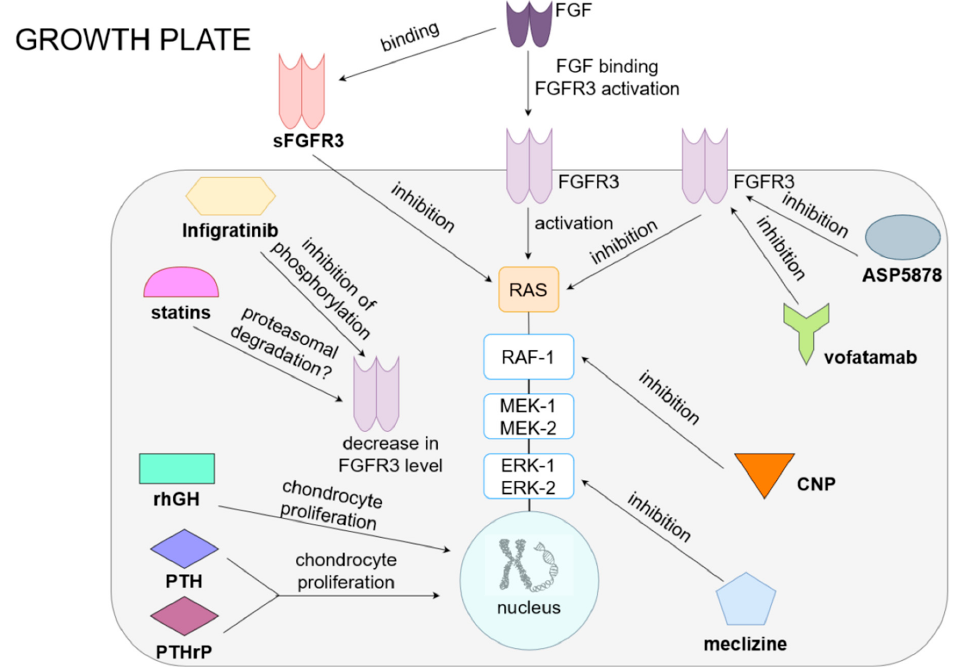
Figure 1. Current and potential treatments for achondroplasia. In the normal growth plate, FGF acts on FGFR3, causing the activation of RAS and the MAPK pathway (RAF, ERK and MEK), resulting in the inhibition of chondrocyte prolifera- tion and differentiation and a reduction in extracellular matrix synthesis. Drugs for achondroplasia include preparations that influence the function of the FGFR3 receptor and MAPK pathways and directly act on chondrocytes. The first group includes, among others, drugs that inhibit the receptor (ASP5878, which is an inhibitor of FGFR3, and vofatamab, an anti- FGFR3 antibody), as well as drugs that reduce the concentration of FGFR3 (infigratinib, which inhibits receptor phosphor- ylation, or statins, potentially causing proteasomal degradation of this molecule). The drug that competes with FGFR3 for a ligand is sFGFR3, a soluble receptor that, by binding to FGF, reduces its effect on the growth plate. Drugs that inhibit the MAPK pathway are CNP analogs, which inhibits RAF-1, and meclizine, which inhibits ERK. By acting on FGFR3 or MAPK, all of these drugs consequently increase the proliferation and differentiation of chondrocytes, improving bone elongation growth. RhGH and PTH or PTHrP have a direct stimulating effect on the proliferation and differentiation of chondrocytes. Table 3. Drawbacks of different drug therapies in achondroplasia.